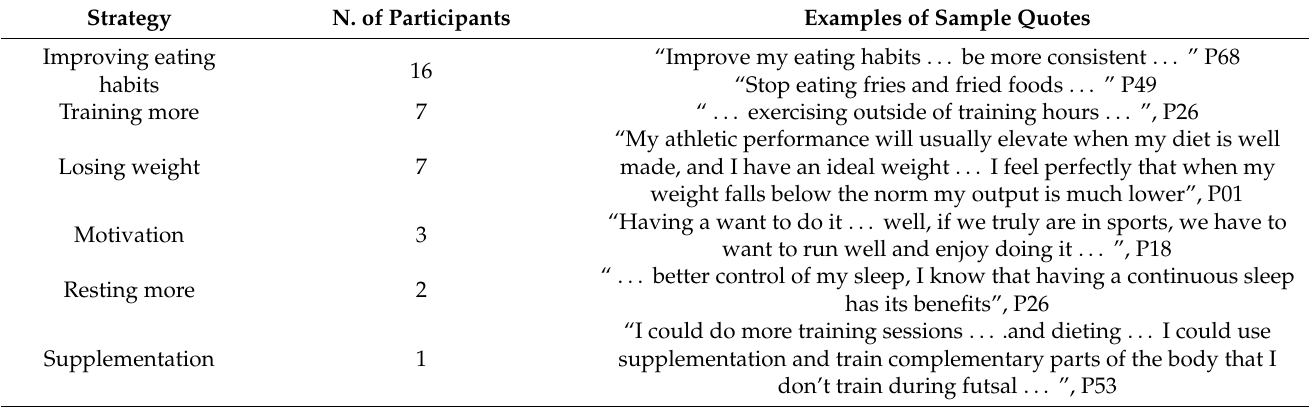
Table 6. Strategies for improving sports